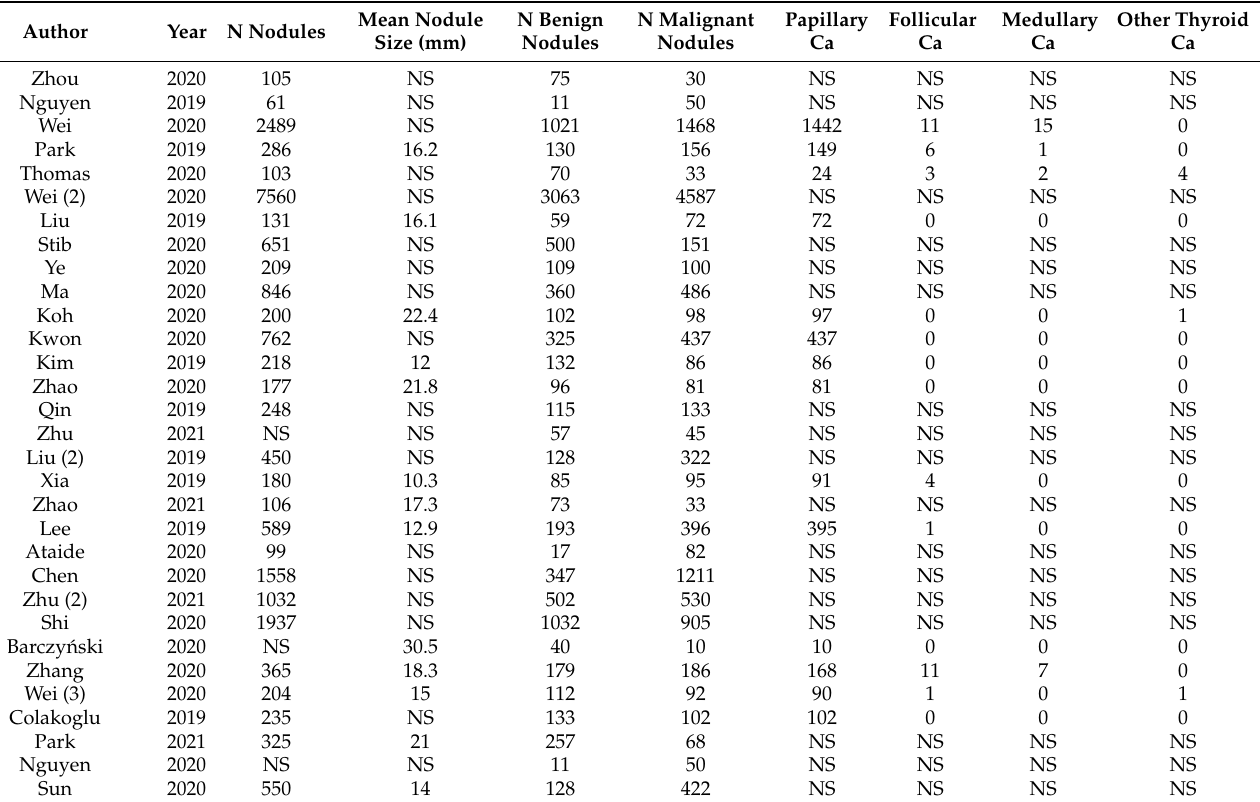
Table 2. Study characteristics and